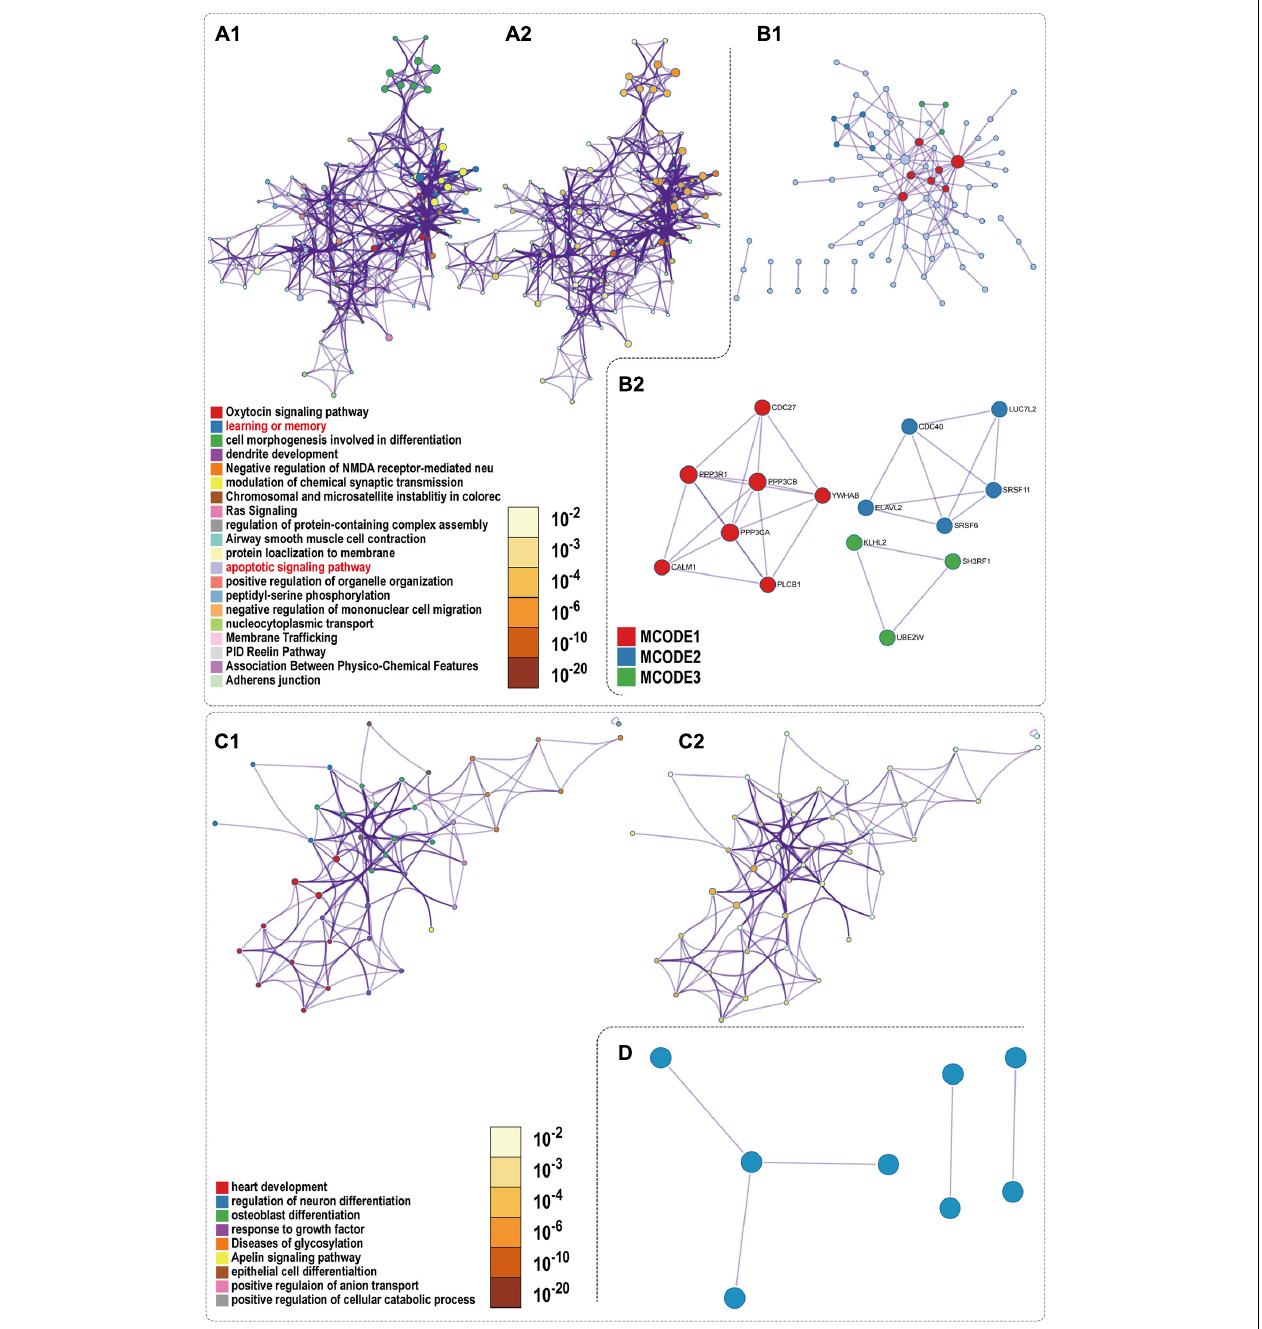
FIGURE 7 | PPI network and enrichment terms of mRNAs of Down ceRNA and Up ceRNA. (A1,C1) Colored by cluster ID; (A2,C2) colored by p -value; (B1,D) Protein-protein interaction network; (B2) MCODE components.